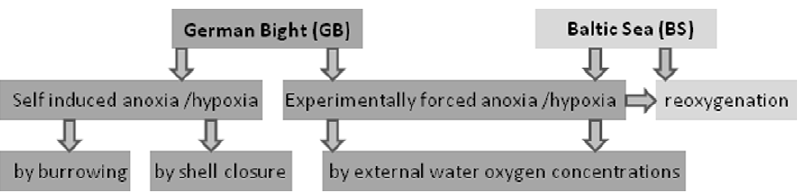
Figure 1. Flow diagram of the experimental design to generate the gill samples of A.islandica investigated in the present study from animals under self induced and experimentally forced hypoxia and anoxia as well as after re-oxygenation.